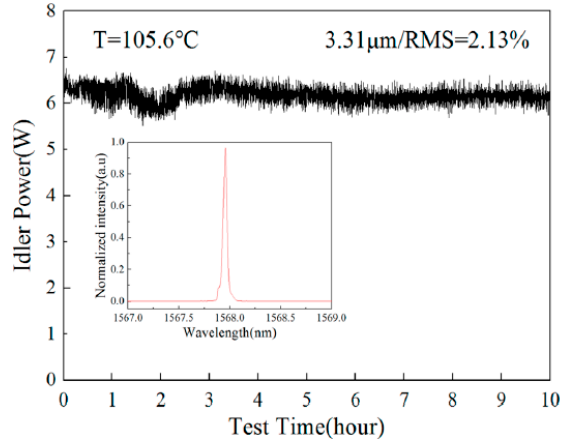
Figure 4. The long time power stability of 3.31 μ m. Inset: the spectrum of the signal.